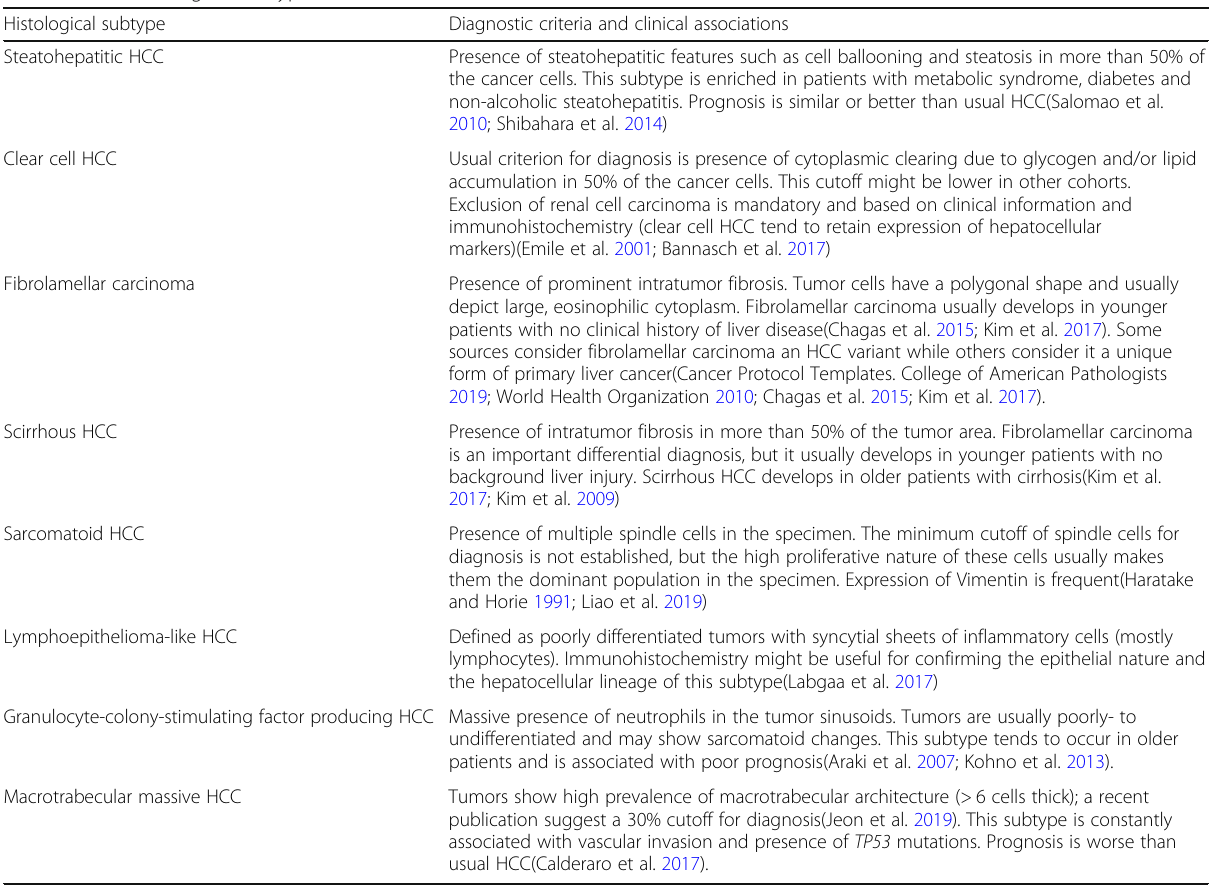
Table 2 HCC histological subtypes Histological subtype Diagnostic criteria and clinical